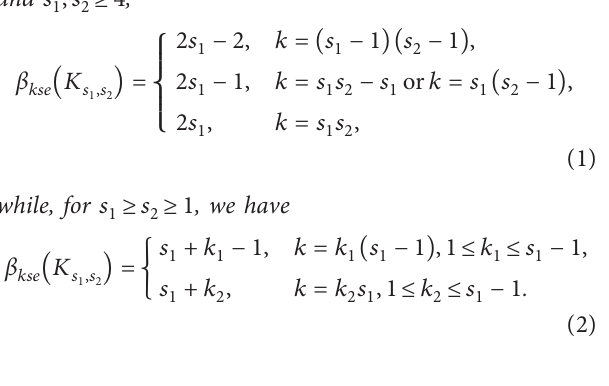
Figure 1. A set W � l for H . It can be seen that, for 3 ≤ p ≤ q , the k -size edge resolving set for graph H exist only for k � 1.